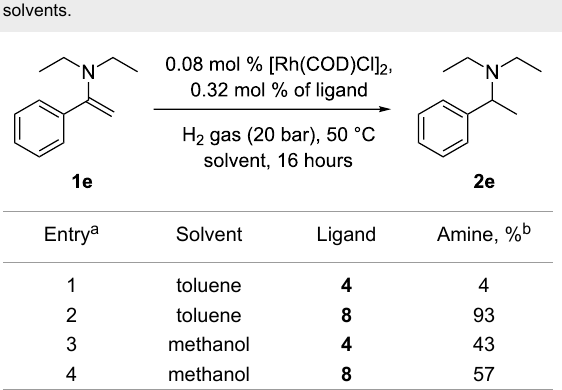
Table 2: Hydrogenation of enamine 1e in toluene and methanol as